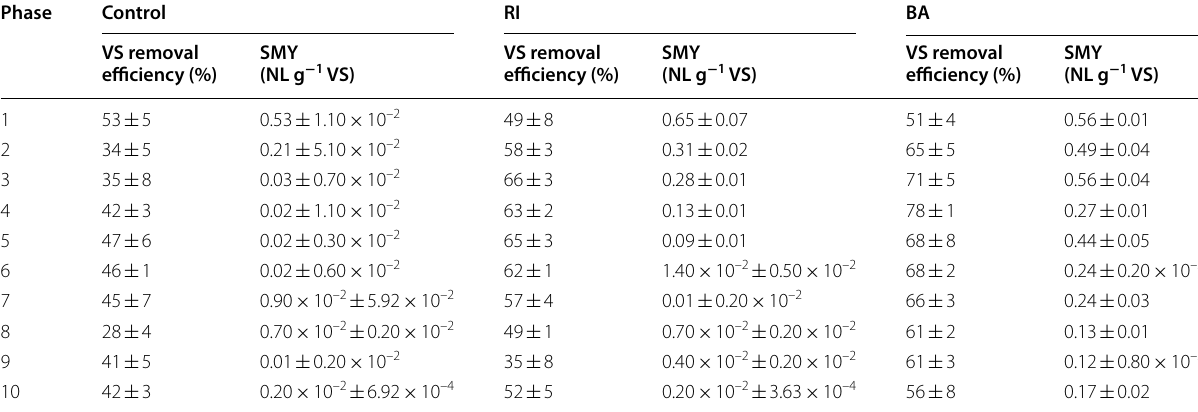
Table 3 Specific methane yield, electrical conductivity, and VS removal rate of digestate from different experimental reactors Phase